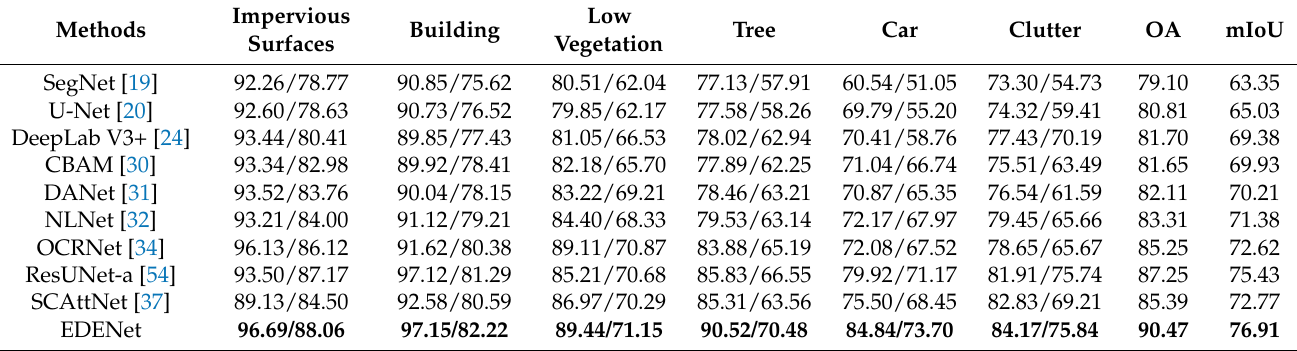
Table 4. Results on Vaihingen dataset. Accuracy of each category is presented in the OA/IoU